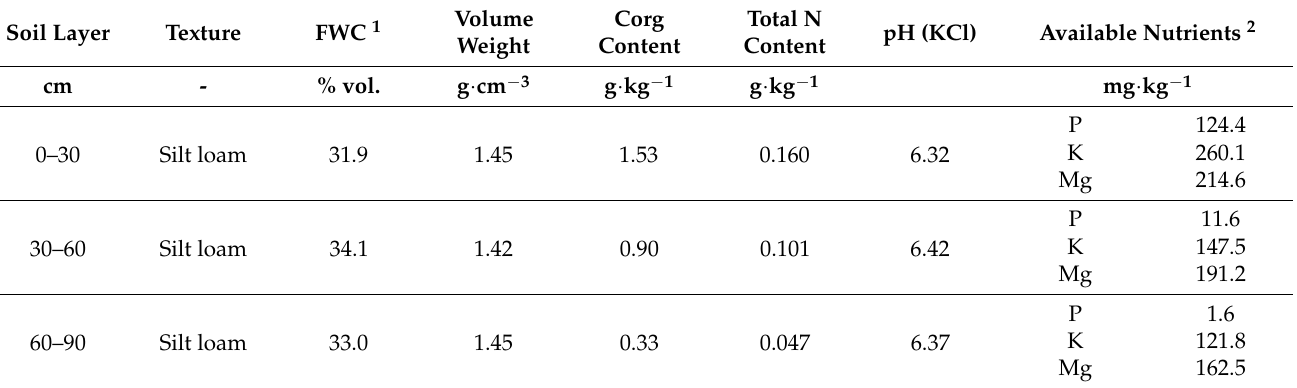
Figure 2. Daily precipitation sums, evapotranspiration (ET), and irrigation doses in experimental years (figure above). Average relative values of available soil water content (ASWC) (figure below). Apple trees ( Malus domestica ) of the ‘Red Jonaprince’ variety, planted in 2013, were monitored. The cultivation form is a slender spindle with a ‘click’ pruning modification. The trees were planted in spacings of 3.5 × 1.2 m, with a 1.5 m width herbicide strip under the crown of the trees. The grass strips between the tree rows were periodically mowed. All variants were fertilized annually with the same dose of NPK fertilizer (16.5/16.5/16.5), 769 kg/ha. Half of the dose was applied to the soil surface on the herbicide strips in April, and the other half in May. Detailed site and set data are shown in Table 1. Table 1. Soil and agrochemical data of orchard in Holovousy.